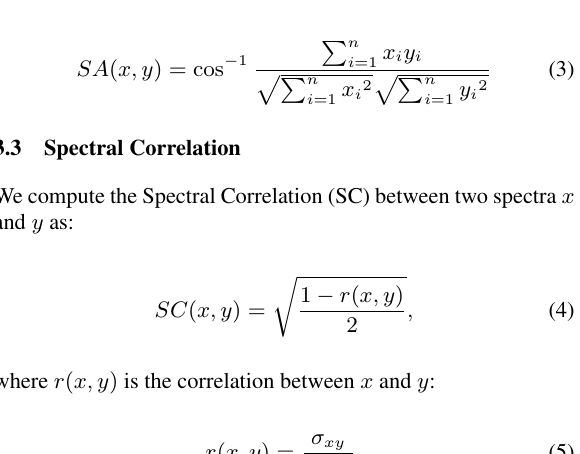
Figure 3: The 41 spectra analyzed, belonging to three classes of